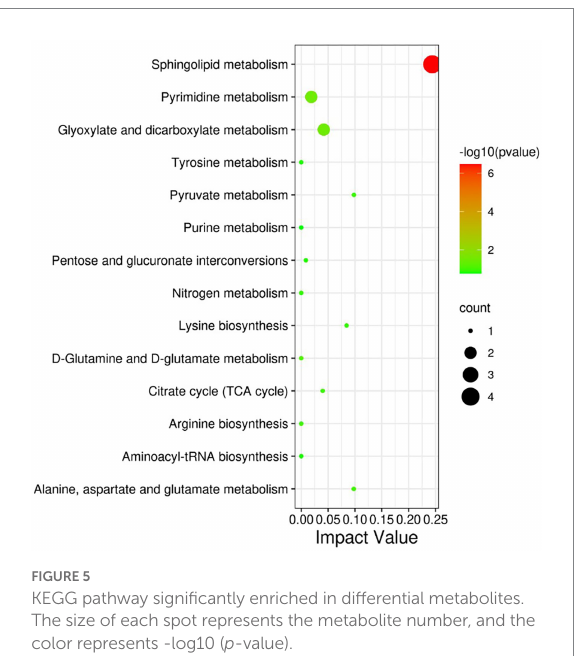
FIGURE 4 Volcano plot by metabolomics analysis.